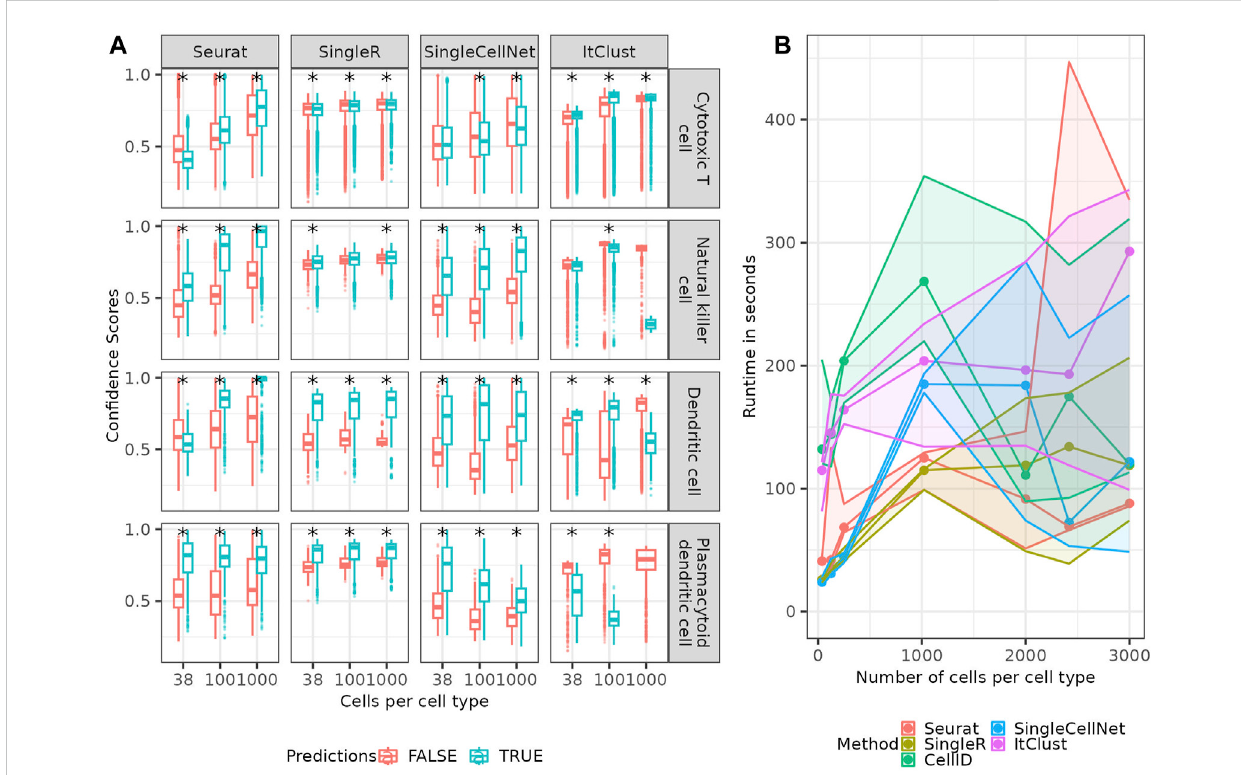
FIGURE 7 Con fi dence scores and runtime. (A) Boxplots (see Methods) of con fi dence-scores for the predicted cell types depending of true and false predictions of each of the methods providing con fi dence scores for four example cell types. The star signs indicate signi fi cant ( p -value < 0.05, see Methods) difference between the False and True predictions. (B) runtime in seconds on a CentOS7 cluster with a memory limit of 16G on one core with 8CPU